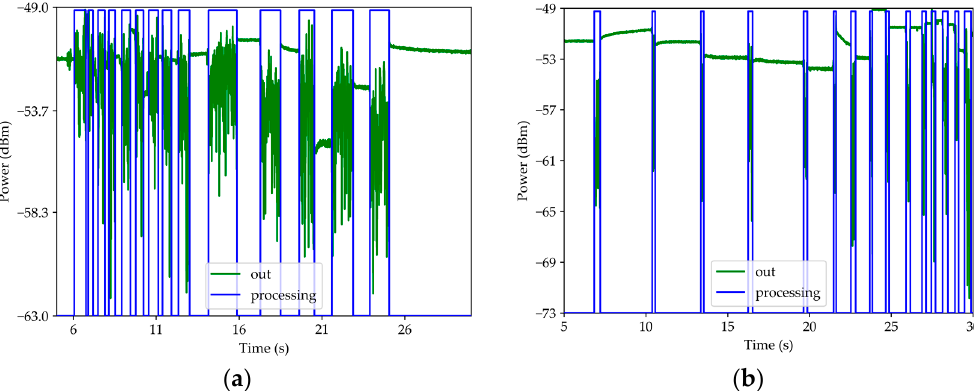
Figure 8. Sensor response for a grid scan: ( a ) path 1 and ( b ) path 2.